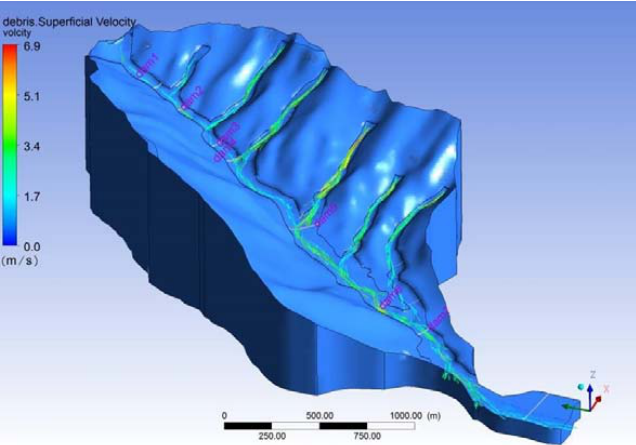
Figure 8. Debris flow velocity vector (time = 1634.2 s).